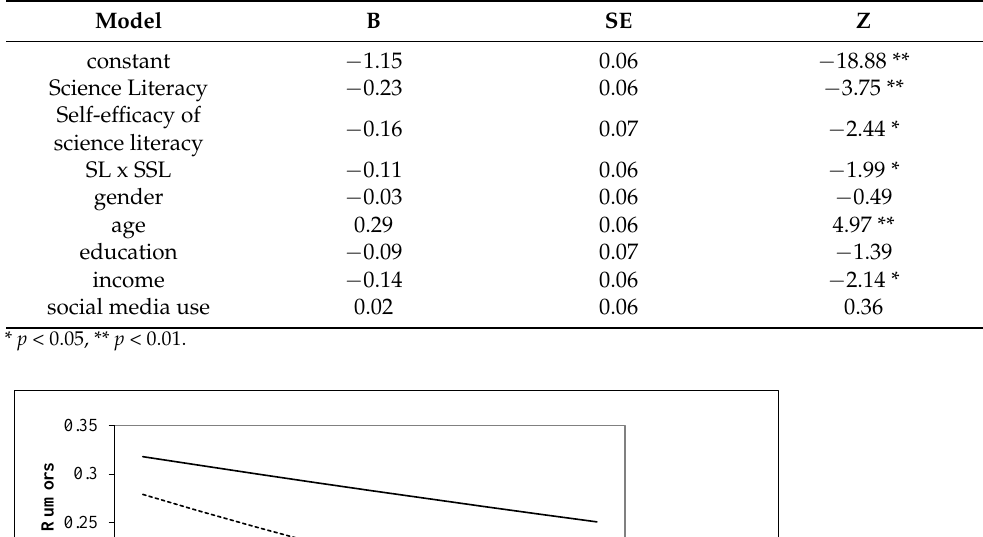
Table 3. Interaction of science literacy and self-efficacy of science literacy.